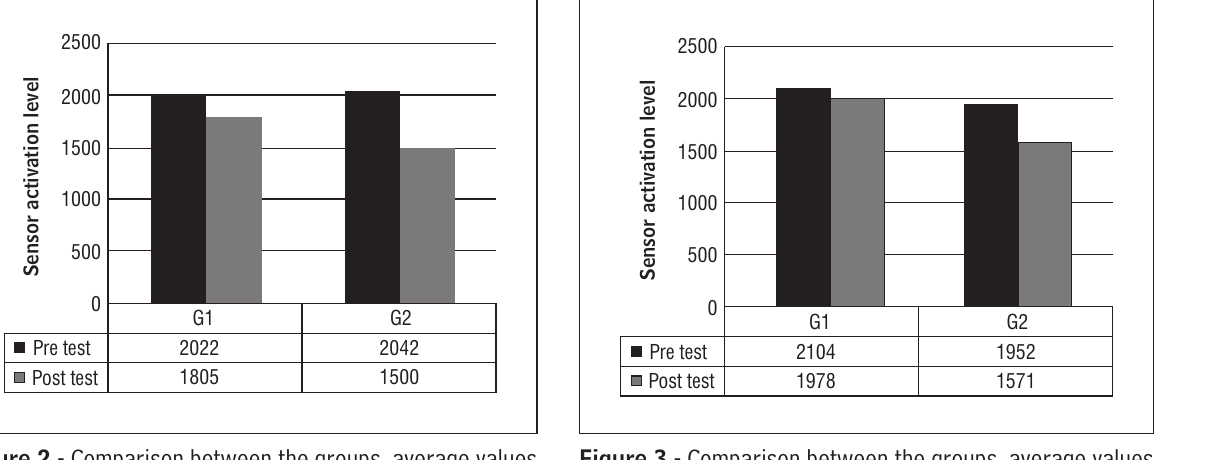
Figure 2 - Comparison between the groups, average values of oscillation on the balance board with feet to- gether, before and after the treatment